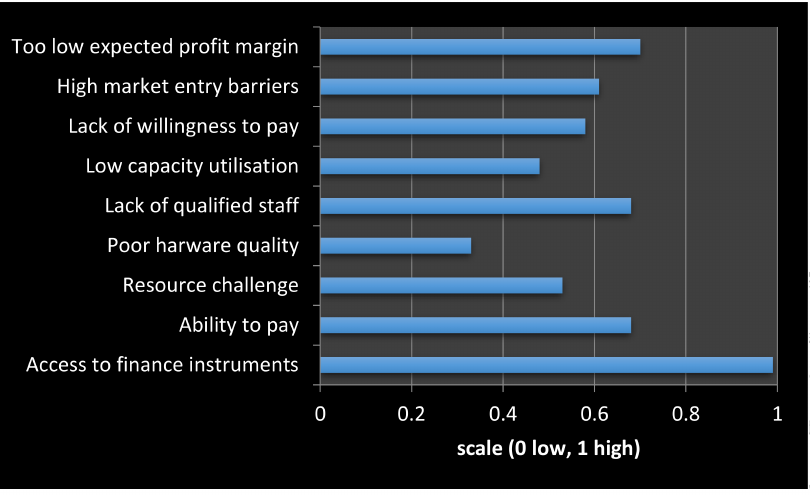
Figure 4. Barriers to scaling-up of mini-grids. Source: